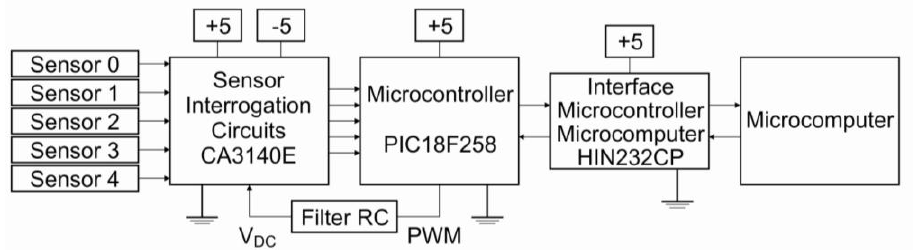
Figure 2. Block diagram of the electronic system of the electronic